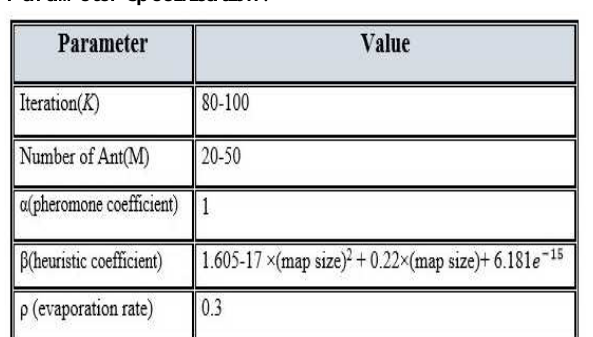
Parameter specification .